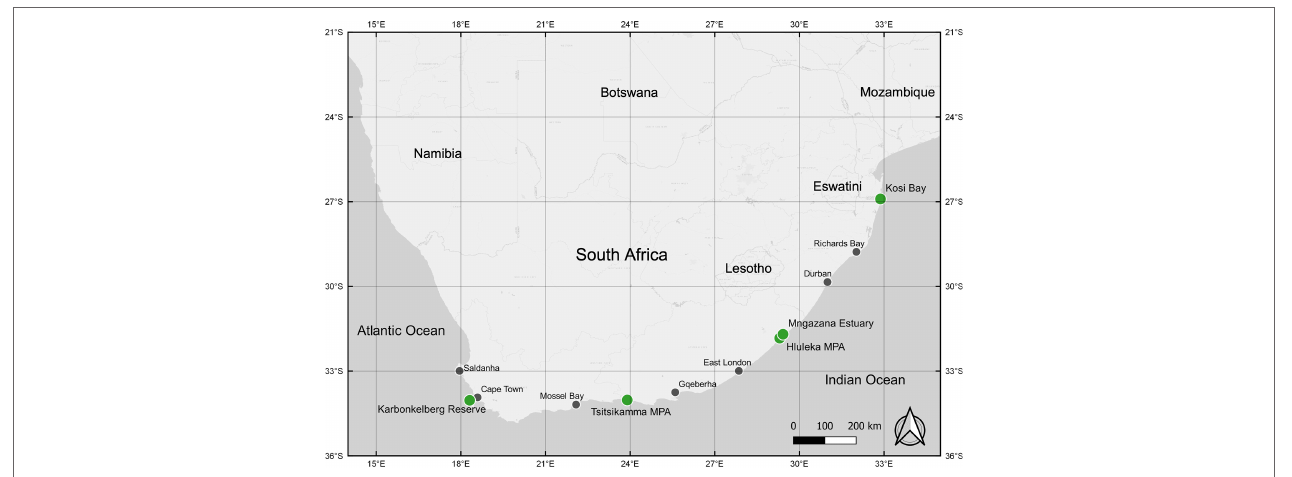
FIGURE 1 | Case study locations (green markers) across South Africa in relation to major coastal cities and towns (grey